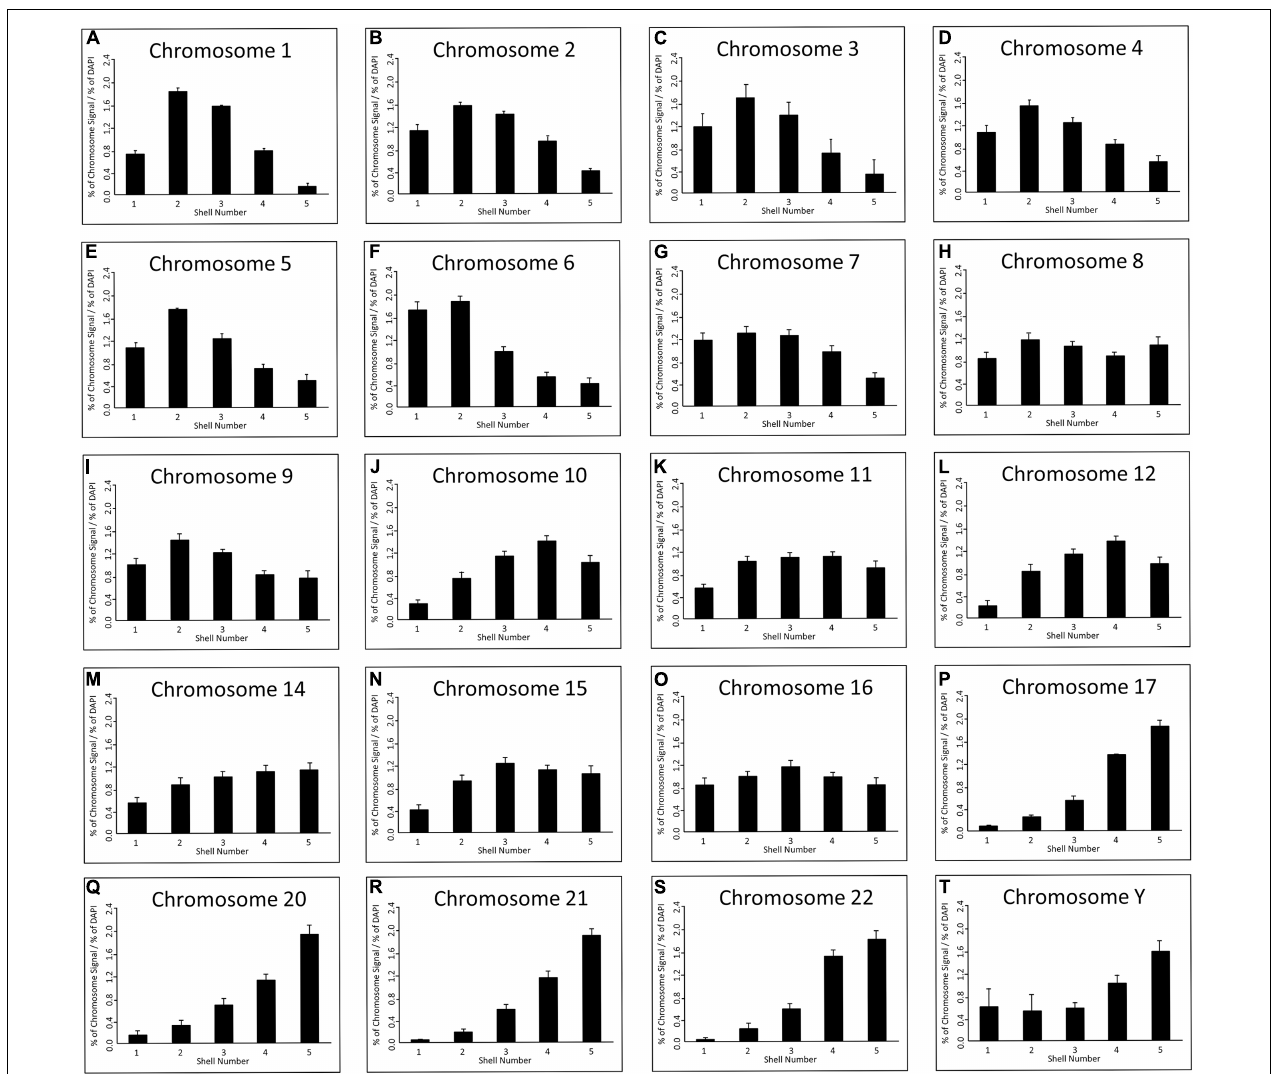
FIGURE 2 | Spatial distribution of human chromosome territories in normal senescent fibroblast nuclei: Digital images ( > 50 nuclei) for each chromosome were analysed by a simple erosion analysis script (Croft et al., 1999; Clements et al., 2016). The script divides the cell nuclei into five shells of equal area and measures the % of signal intensity from both chromosome signal and the DNA (DAPI). The % of chromosome signal is normalised by division of the % of DAPI in each of the eroded shells ( y -axis); and the shell numbers of 1–5 are on the x -axis. The error bars represent the standard error of mean (SEM). Shells 1 and 2 denote the nuclear periphery and shells 4 and 5 the nuclear interior. chromosomes as indicated above each graph in senescent nuclei as visualised by FISH and specific probes and erosion analysis. (A) Chromosome 1, (B) Chromosome 2, (C) Chromosome 3, (D) Chromosome 4, (E) Chromosome 5, (F) Chromosome 6, (G) Chromosome 7, (H) Chromosome 8, (I) Chromosome 9, (J) Chromosome 10, (K) Chromosome 11, (L) Chromosome 12, (M) Chromosome 14, (N) Chromosome 15, (O) Chromosome 16, (P) Chromosome 17, (Q) Chromosome 20, (R) Chromosome 21, (S) Chromosome 22, (T) Chromosome